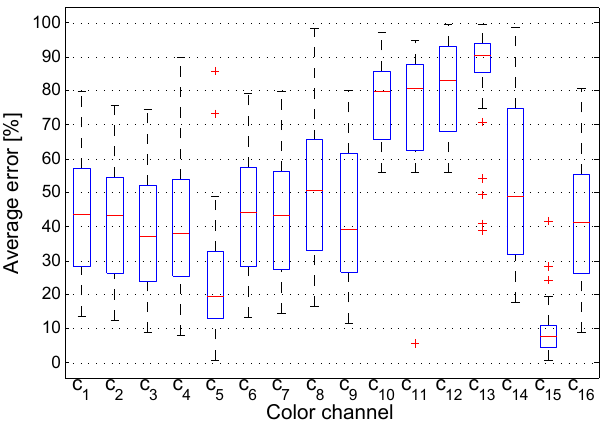
Figure 5. Distribution of the average segmentation error for differ- ent color channels of the HDR radiance map, across all the images of the HDR dataset. Within each box, the red line indicates the me- dian, and the bottom and top edges indicate the 25th and 75th per- centiles,